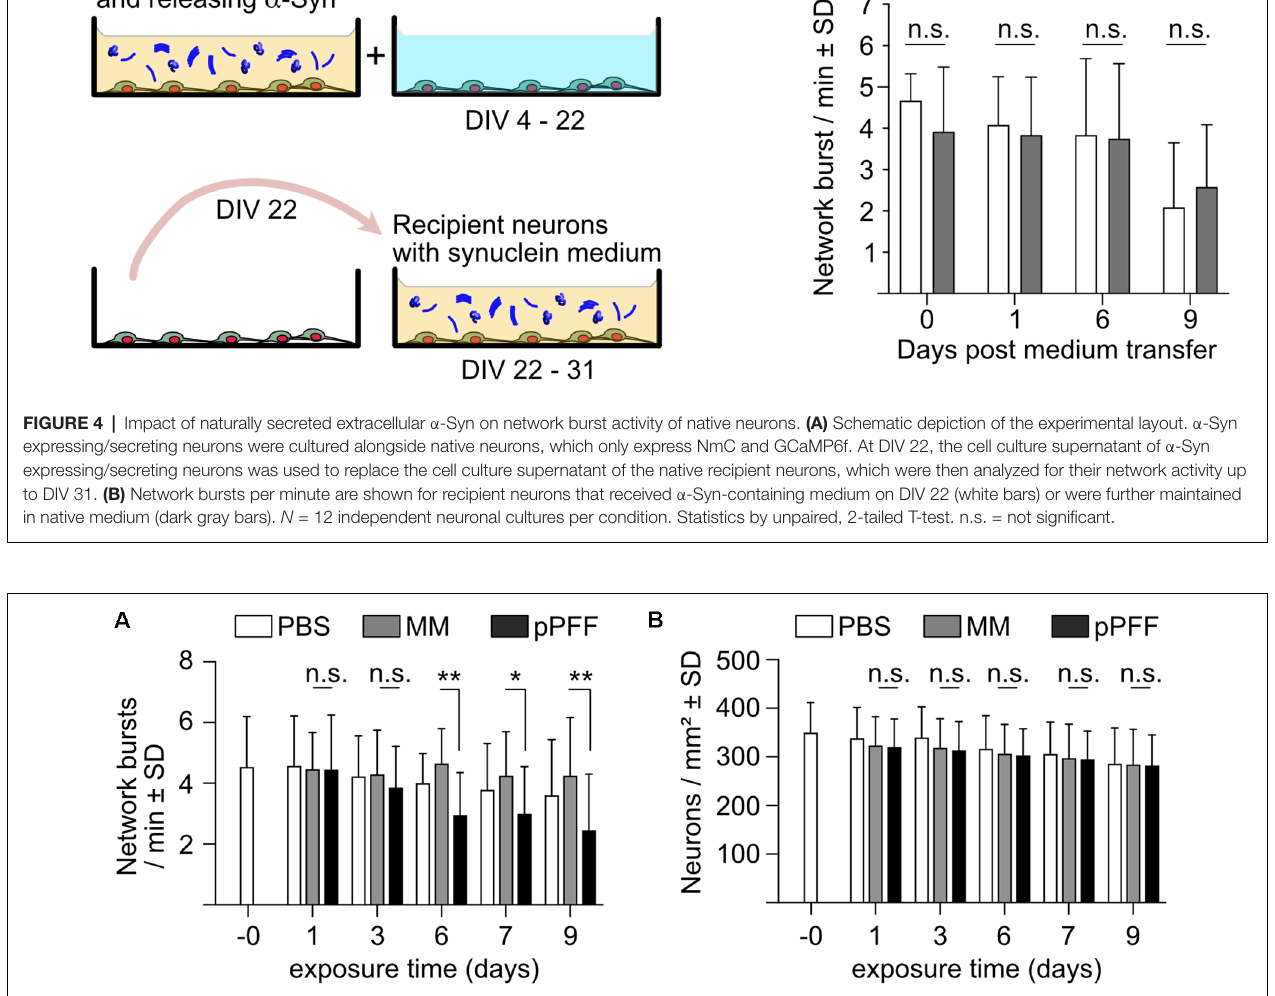
FIGURE 5 | Impact of extracellular recombinant monomers and processed fibrils of α -Syn on network burst activity. (A) Neuronal network bursts per minute in cultures exposed to PBS (white bars), monomeric α -Syn (MM, gray bars), or ultrasound-processed preformed fibrils (pPFF) at the indicated times after addition of 0.4 µ M of each α -Syn species. (B) Neuron numbers in cultures exposed to PBS (white bars), monomeric α -Syn (MM, gray bars), or ultrasound-processed preformed fibrils (pPFF) at the indicated times after the addition of 0.4 µ M of each α -Syn species. Statistics by 1-way ANOVA. N = 22 independent cultures for PBS, 24 for MM and 26 for pPFFs (A,B) . n.s. = not significant; * p < 0.05; ** p < 0.01; Statistical power (1 – β error probability) = 99% (A) , DIV 6, 78% (A) , DIV 7, 88% (A) , DIV